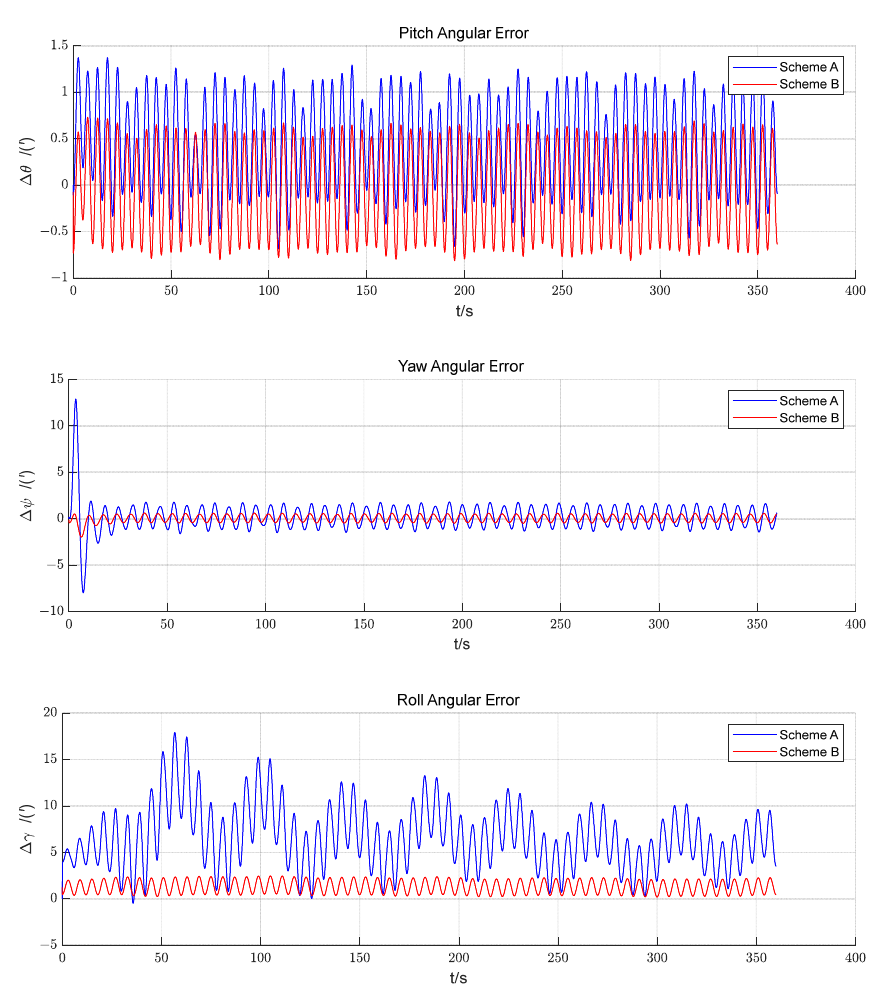
Figure 7. Three-axis attitude error curves for the FA of scheme A and the last FA of scheme B. A stochastic simulation was performed. In the conventional approach, the roll angle error enters the error band [ 1 (cid:48) , 10 (cid:48) ] after completing the alignment, while the roll angle error enters the error band [ 0 (cid:48) , 3 (cid:48) ] in the proposed method. Since the proposed method utilizes the SINS data from the CA stage in the FA, more information is obtained at the same time.